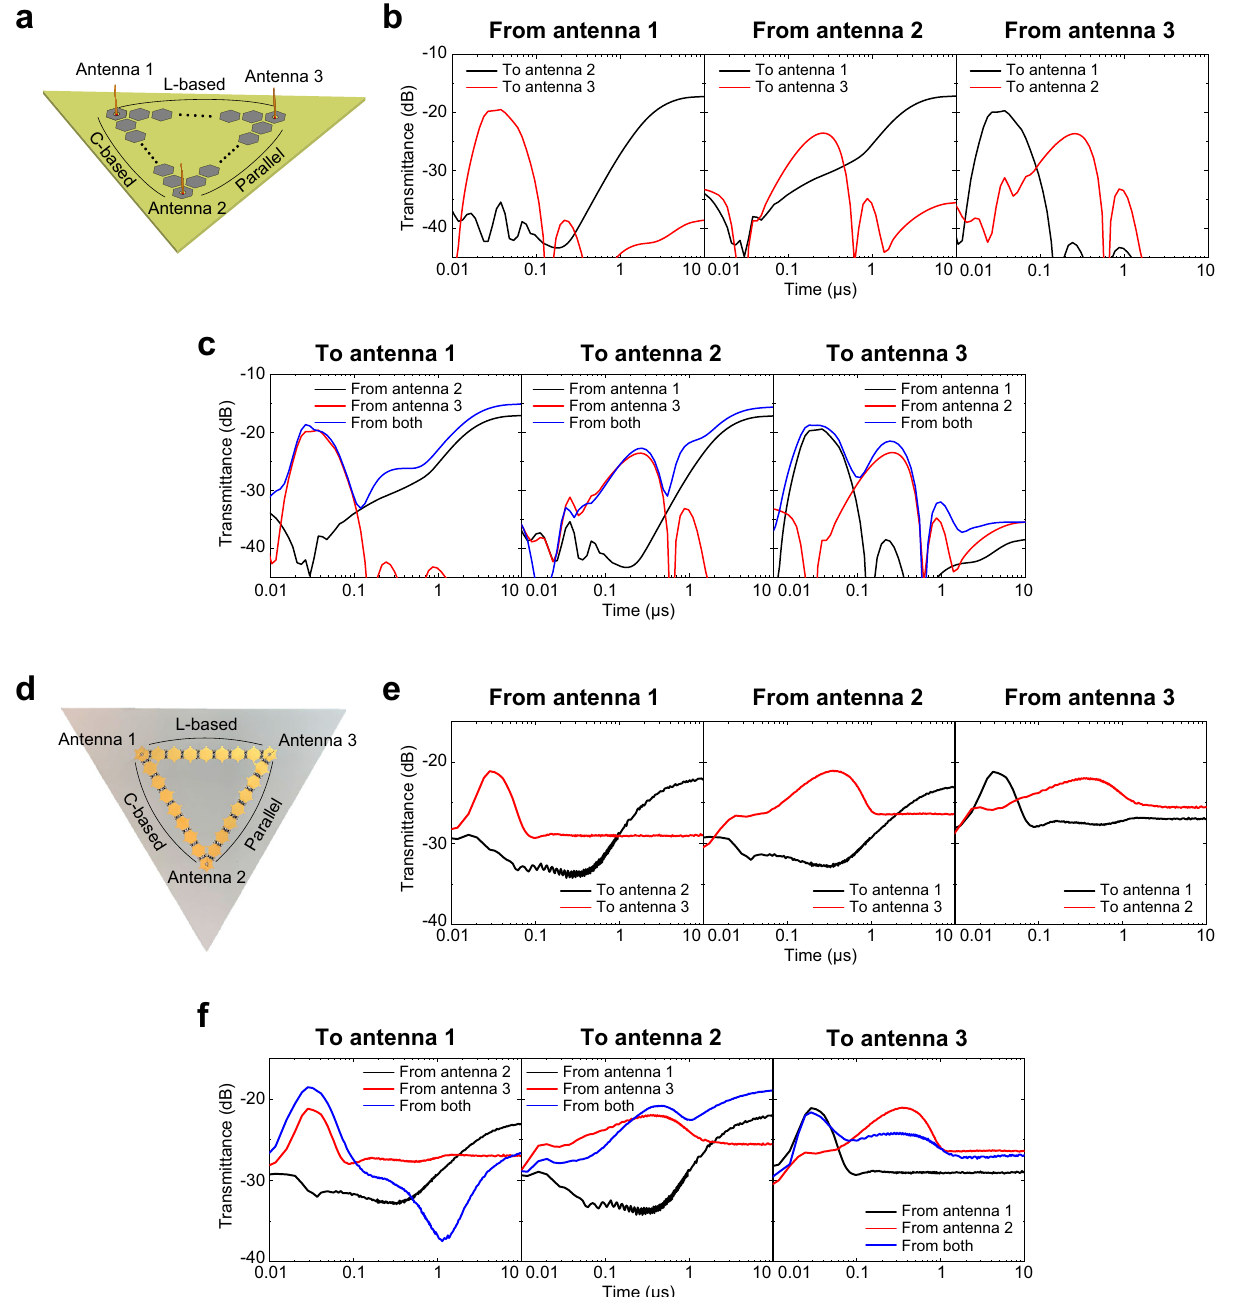
Fig. 6 | Mutually pulse-width-selective communication system. a Simulation model using three antennas connected by either C-based, L-based or parallel waveform-selective metasurface line. The frequency and input power were set to 2.36GHz and 10dBm, respectively. b Simulation results of transmittances from (left) antenna 1, (center) antenna 2, and (right) antenna 3. c Simulation results of